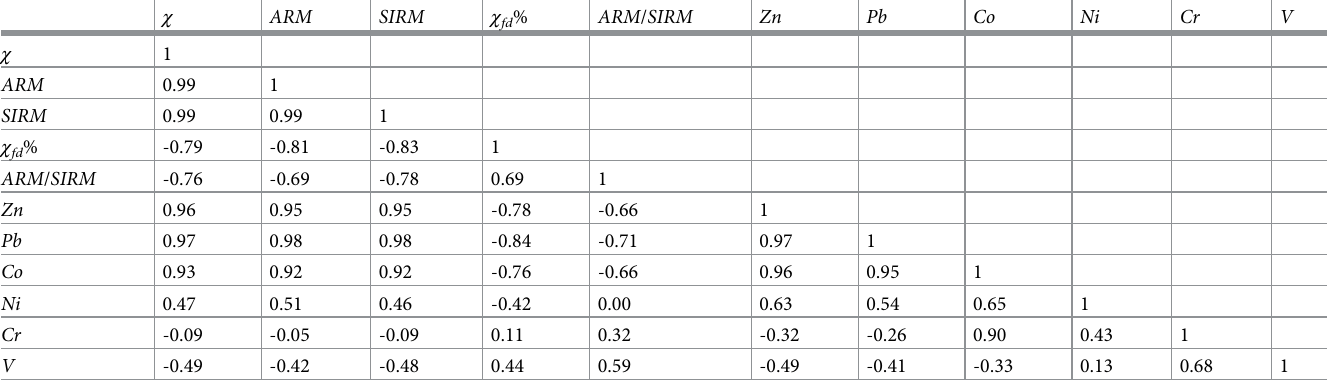
Table 1. Pearson’s correlation coefficients (r) between magnetic properties and heavy metal